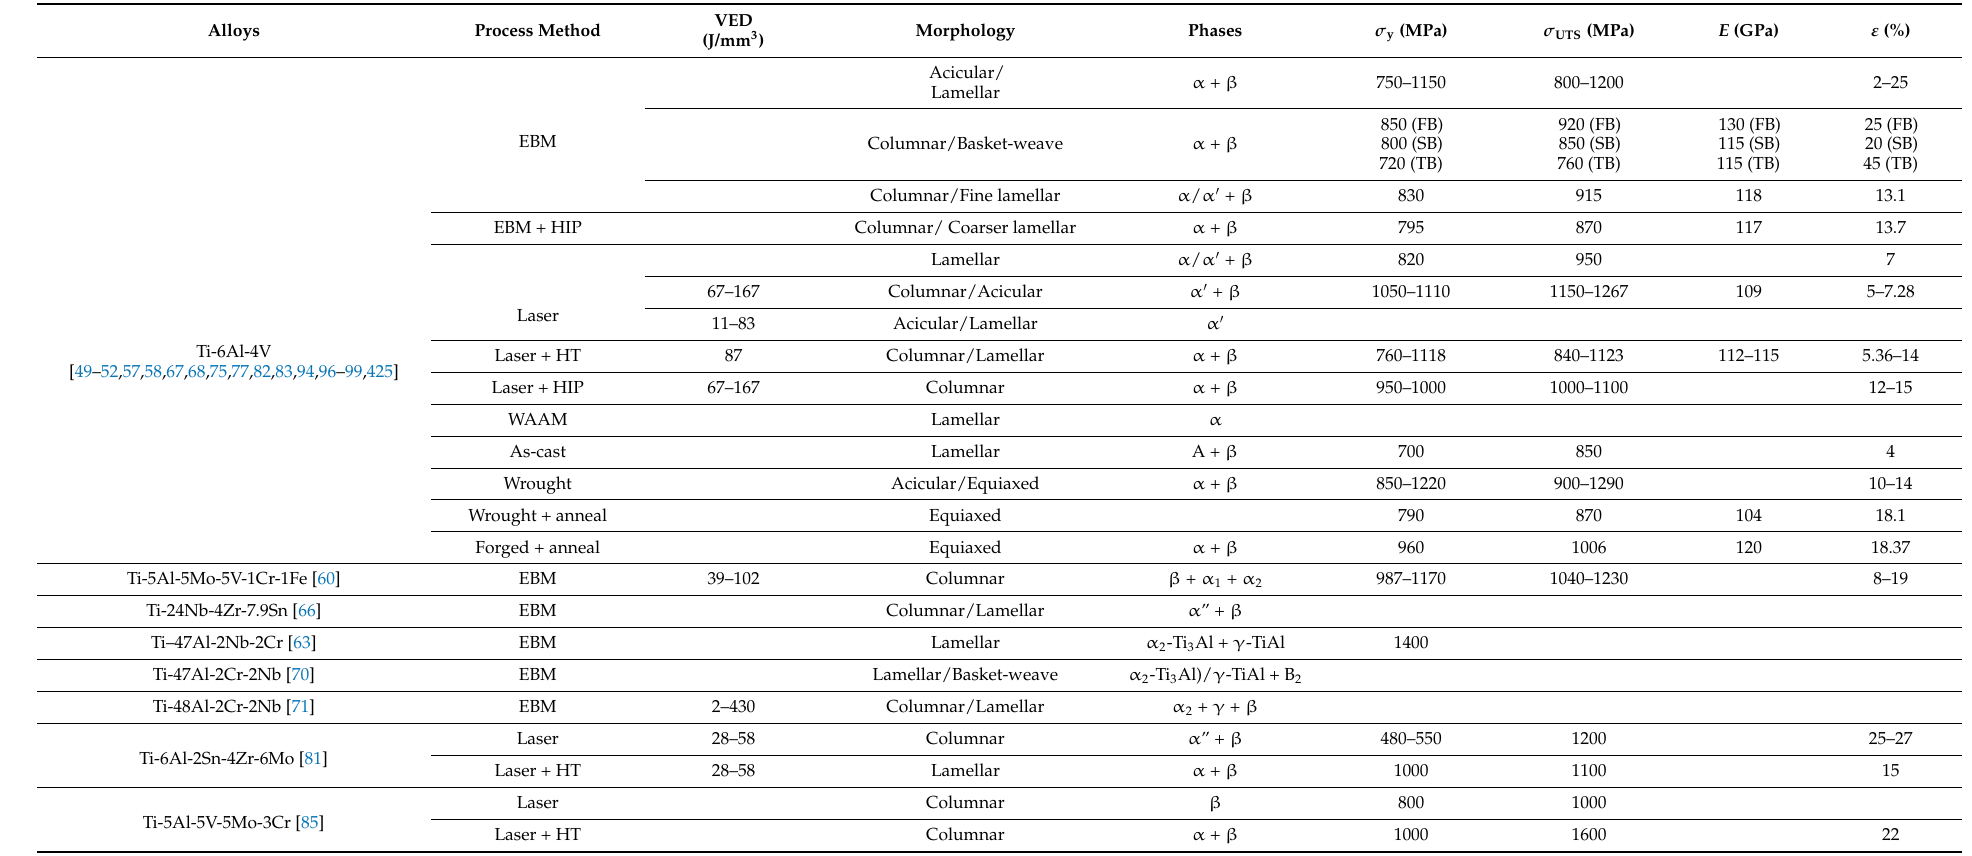
Table 1. Summary of microstructure and mechanical properties of additively manufactured alloys (VED: volumetric energy density; σ y : yield strength at 0.2% offset; σ UTS : ultimate tensile strength; E : elastic modulus; ε : strain; HT: heat treatment; FB: flat built; SB: side built; TB: top built; z: build direction; xy: perpendicular to build direction; HIP: hot isostatic pressing; WAAM: wire arc additive manufacturing; STA: Solution Treating and Aged; S: solutionized; SHT: solutionized heat treatment; HHT: homogenized heat treatment; SS: solid solution; DA: double aging; Q: quenched; C: